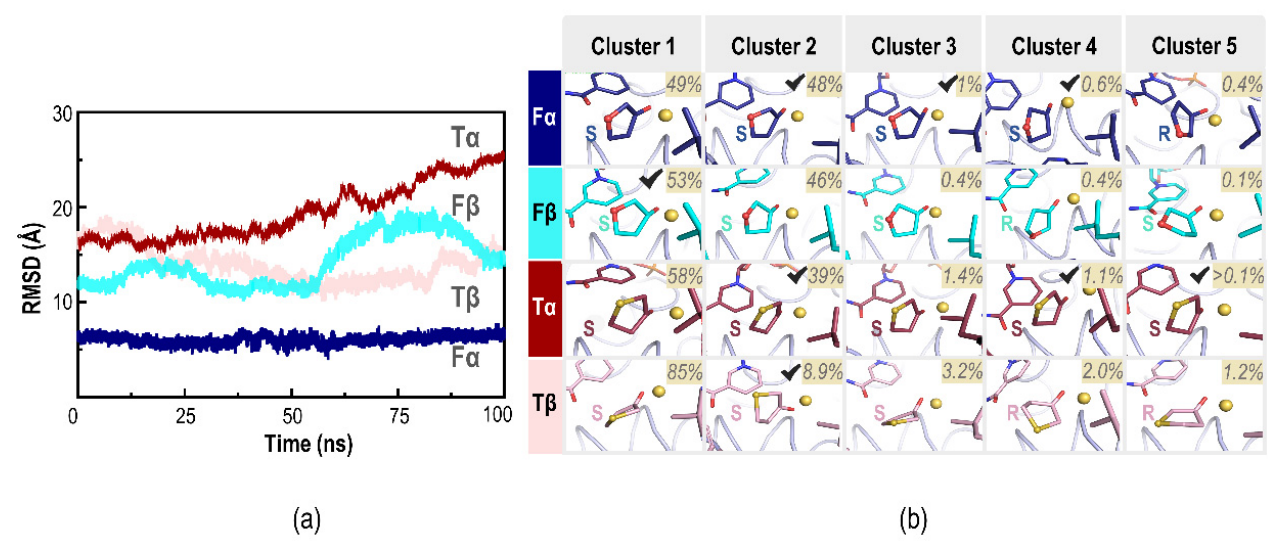
Figure 3. Dynamic structures of substrates in Cp RCR. ( a ) the time-resolved RMSD plot of the 5-m-r heterocylic ketones with the reference of protein backbones, upon the four trajectories starting from the lowest-energy docking poses, ( b ) the clustering analysis of the MD simulations. NADH is shown behind the substrate. The catalytic zinc is shown in yellow orange. The oxygen and the sulfur atoms are indicated with a sphere (colored red and yellow) to determine the substrate orientation (R, up; S, down). The clusters with the attacking distance of coenzyme NADH were marked with black